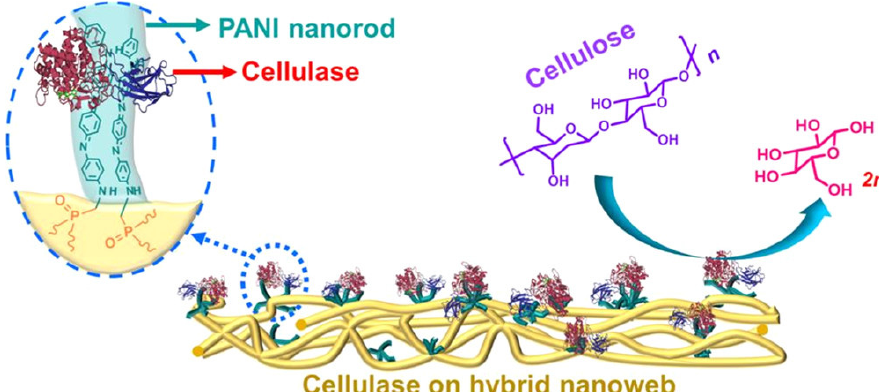
Figure 3. Hybrid cellulase-hydrogel nanobiocatalyst based on PANI nanorods formed on electrospun cationic poly( ε -caprolactone). Reproduced with permission from [72], Elsevier, 2022.